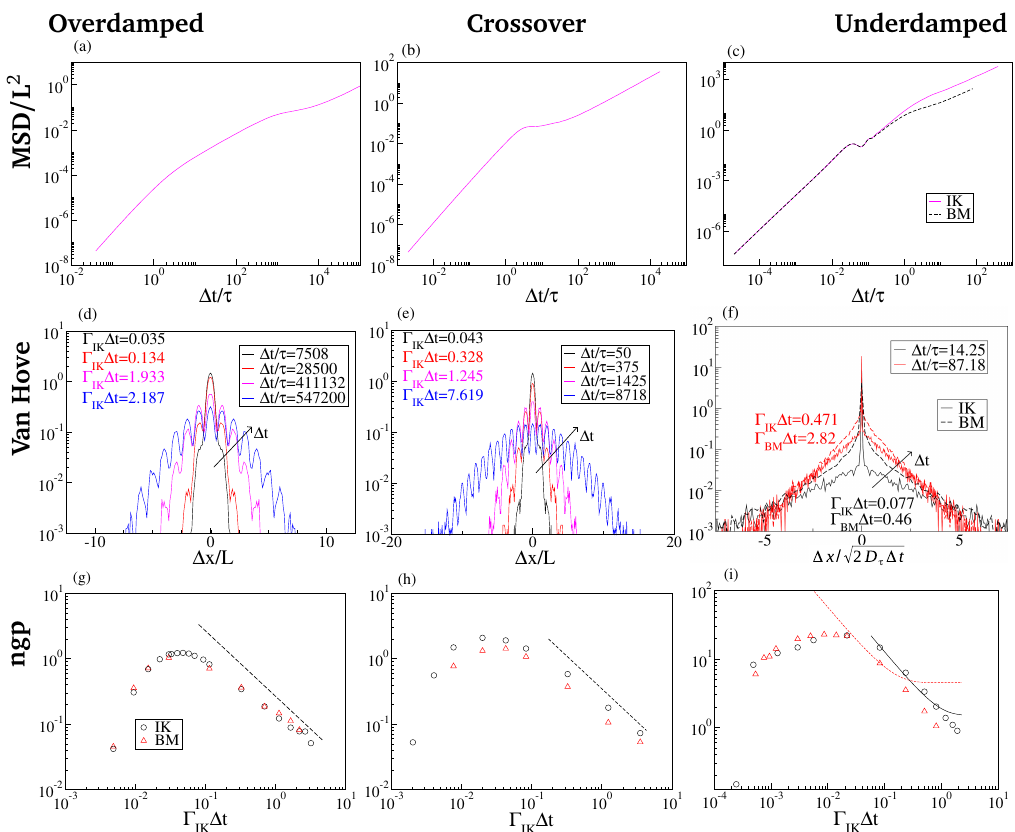
τ = 0.05), at the b τ = 100), where τ = t in the IK b c